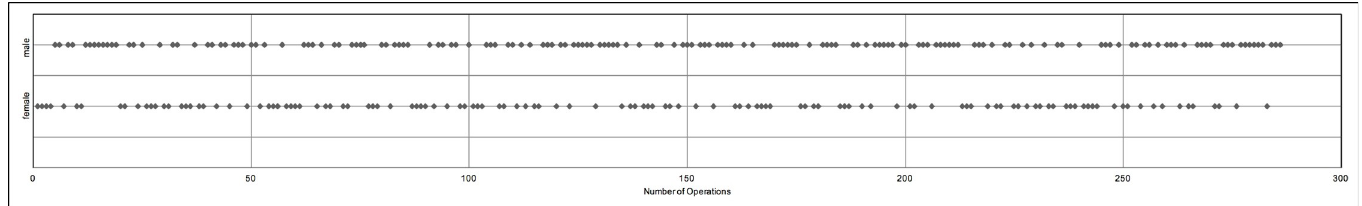
PLOS ONE | https://doi.org/10.1371/journal.pone.0214513 April 12,